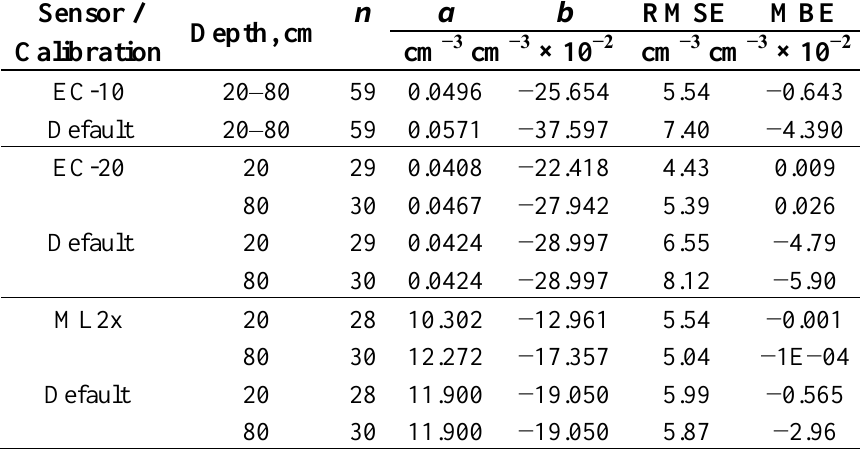
Table 5. Calibration functions of the EC-10, EC-20, and ML2x site-specific laboratory calibration and default equations and statistical indicators for their accuracy in estimating actual water content.